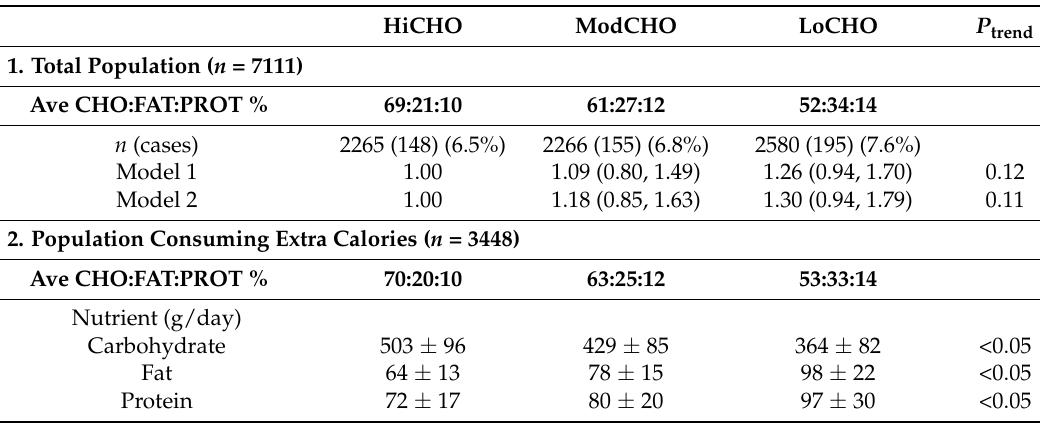
Table 4. Relative risk (95% Confidence interval) of type 2 diabetes across tertiles of low-carbohydrate, high-fat and high-protein diet scores in the Harbin Cohort Study on Diet Nutrition and Chronic Non-Communicable Diseases (Cohort 2,